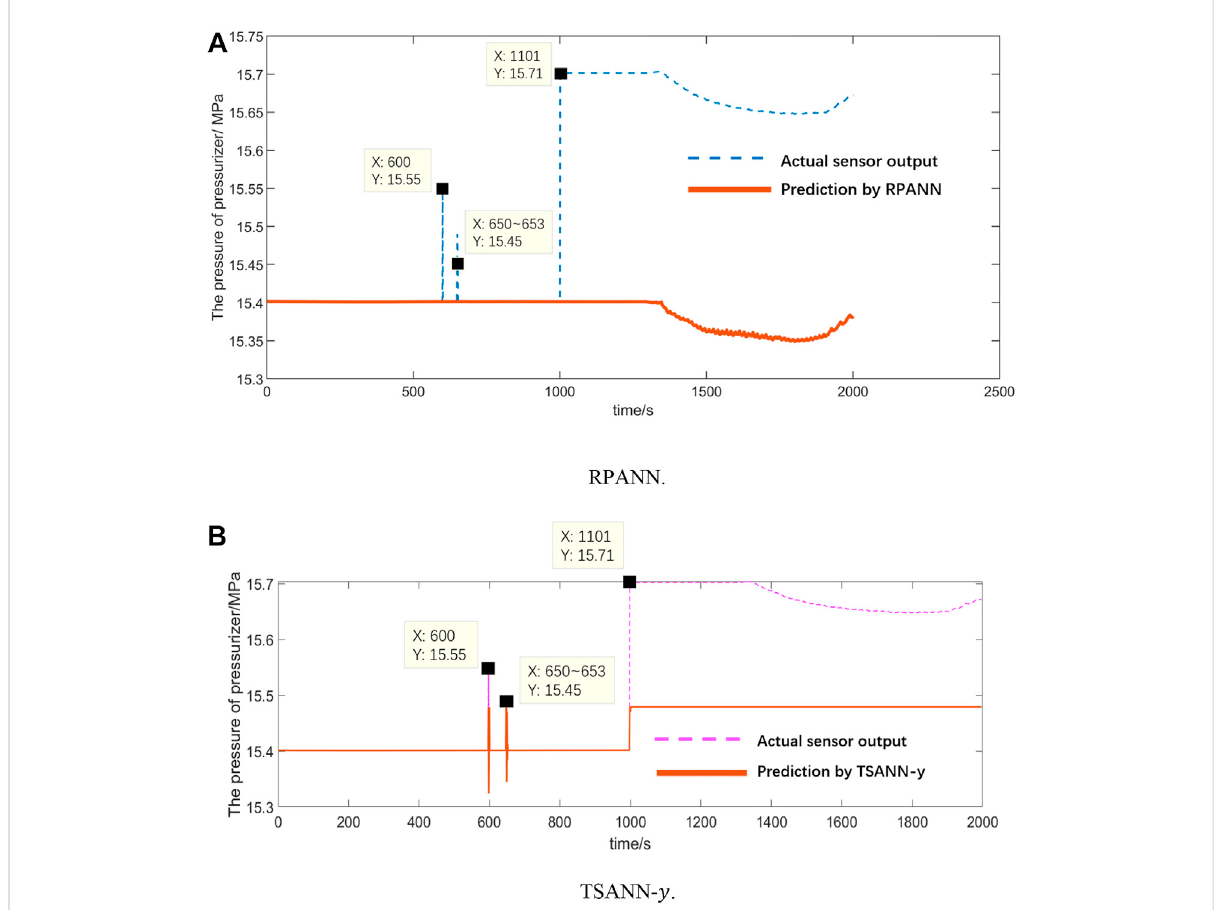
FIGURE 14 Monitoring curve of the pressure in the primary-circuit pressurizer with the RPANN and TSANN for the case of a + 2 % constant-bias fault occurring at 1001 s. (A) RPANN. (B) TSANN- y